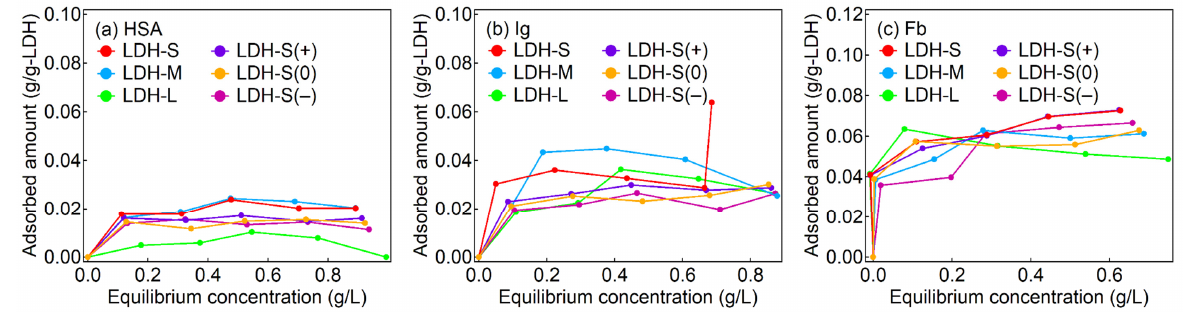
Figure 2. Adsorption isotherms of the proteins of ( a ) HSA, ( b ) Ig and ( c ) Fb for the